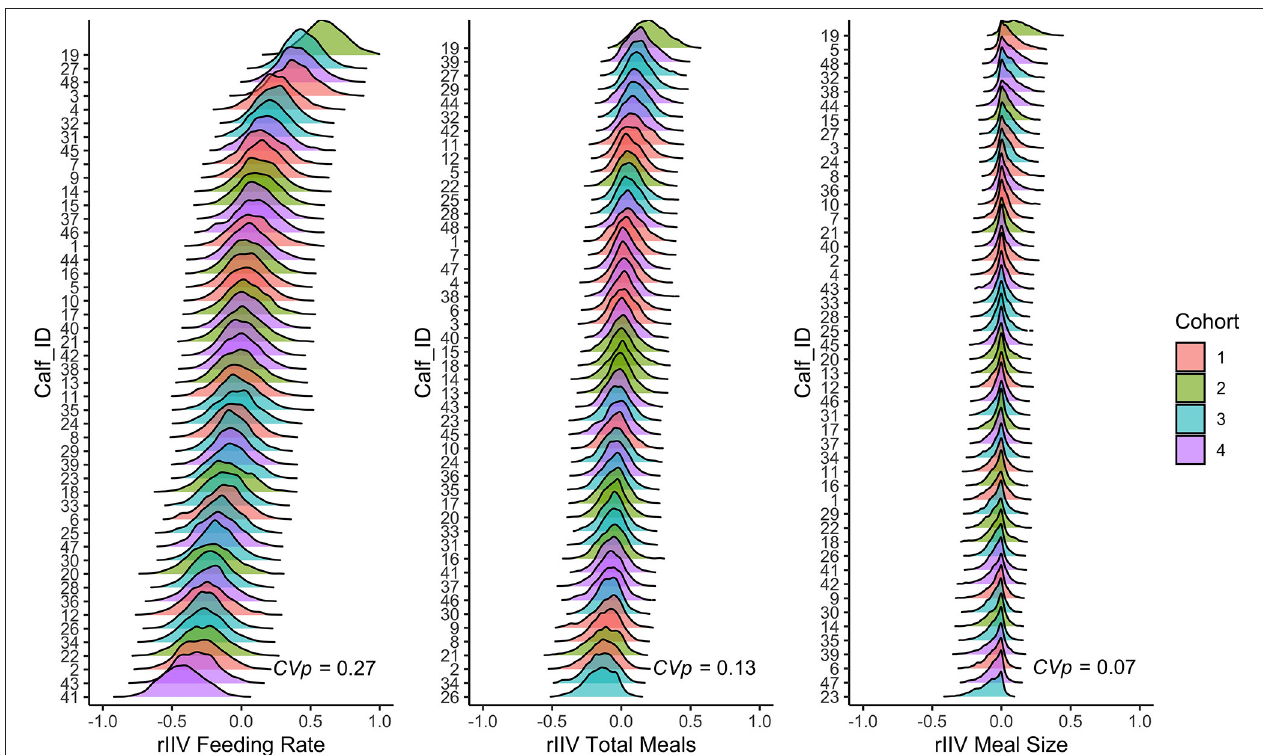
FIGURE 2 | Posterior distributions of residual intraindividual variation (rIIV) from the double hierarchical mixed models for feeding rate, total meals, and meal size for each calf. The models controlled for between individual differences in age, day number, and cohort. Variables were Z-transformed (mean indicate the posterior 95% credible interval, and the different colors correspond to the different cohorts. The coefficient of predictability (CVp) is reported in the bottom right corner of each